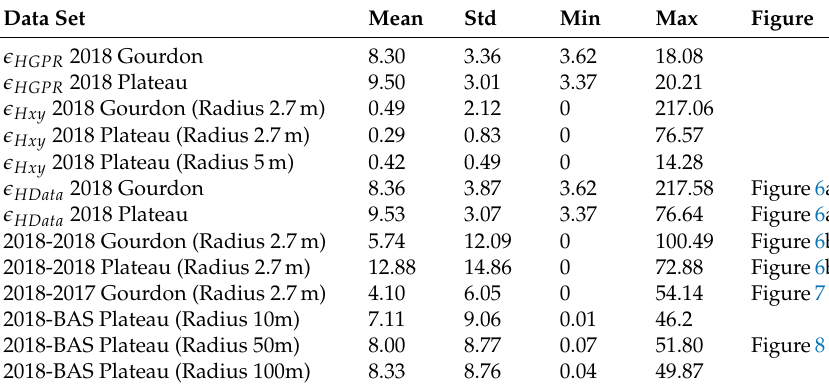
Table A2. Statistics for the errors and different datasets in the result section. Data